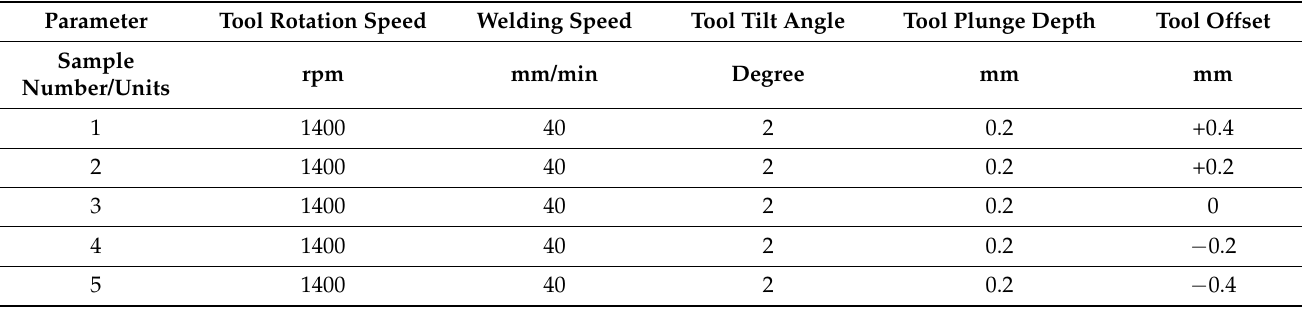
Table 3. FSW process